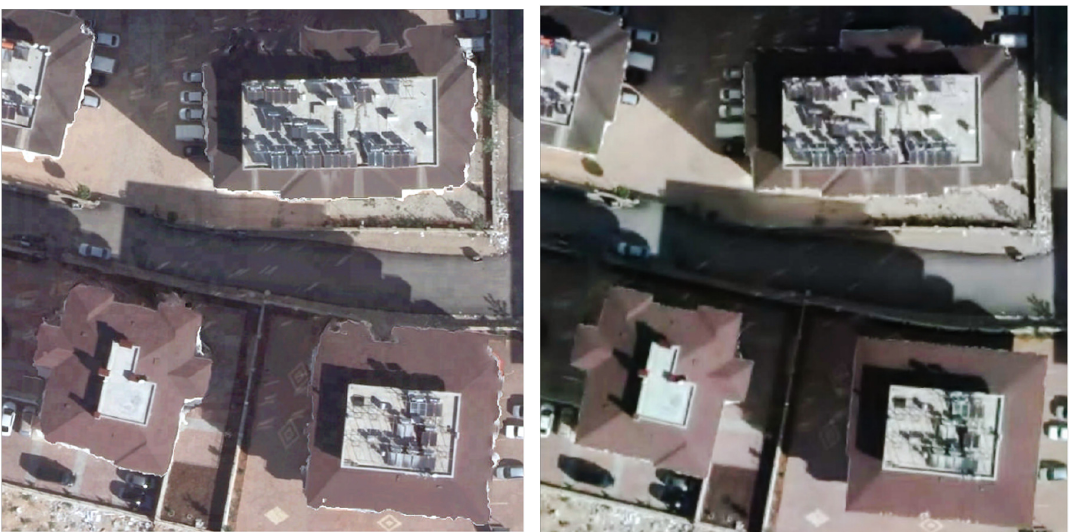
Figure 15. Radiometric comparison of ordinary orthophoto product ( left ) and the true orthophoto ( right ). The differences are especially noticeable at the roof edges.